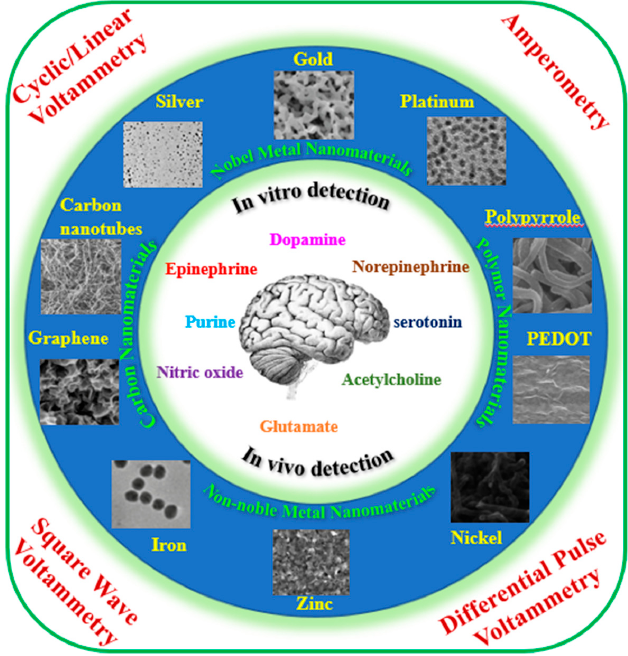
Figure 1. Schematic representation of the application of various nanoparticles for the in vitro and in vivo detection of neurotransmitters using different electrochemical methods.